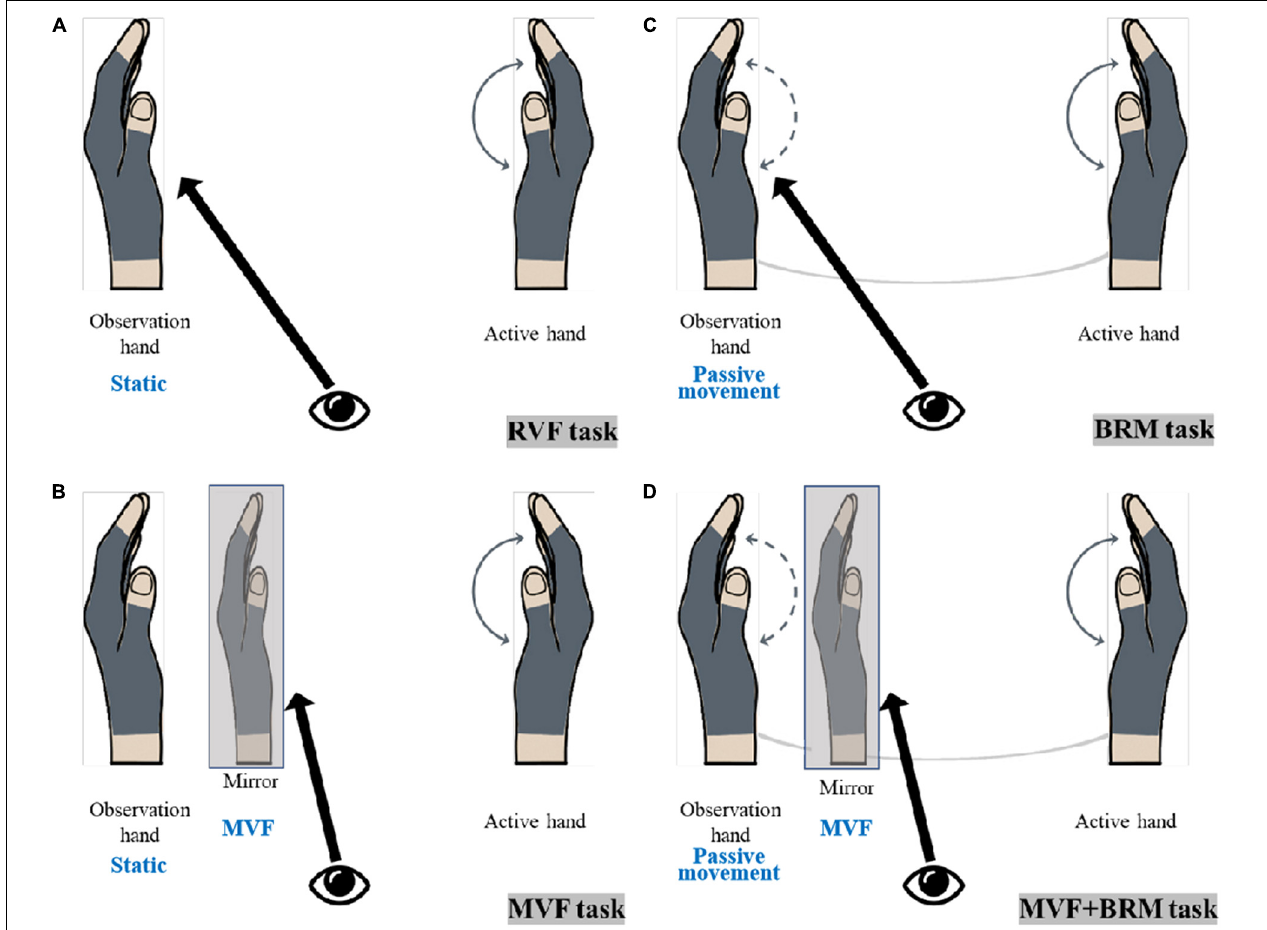
FIGURE 1 | The diagram of visual feedback tasks. (A) RVF Task (real visual feedback task); (B) MVF task (mirror visual feedback task); (C) BRM task (bilateral robotic movement task); (D) MVF + BRM task (Mirror visual feedback combined with bilateral robotic movement